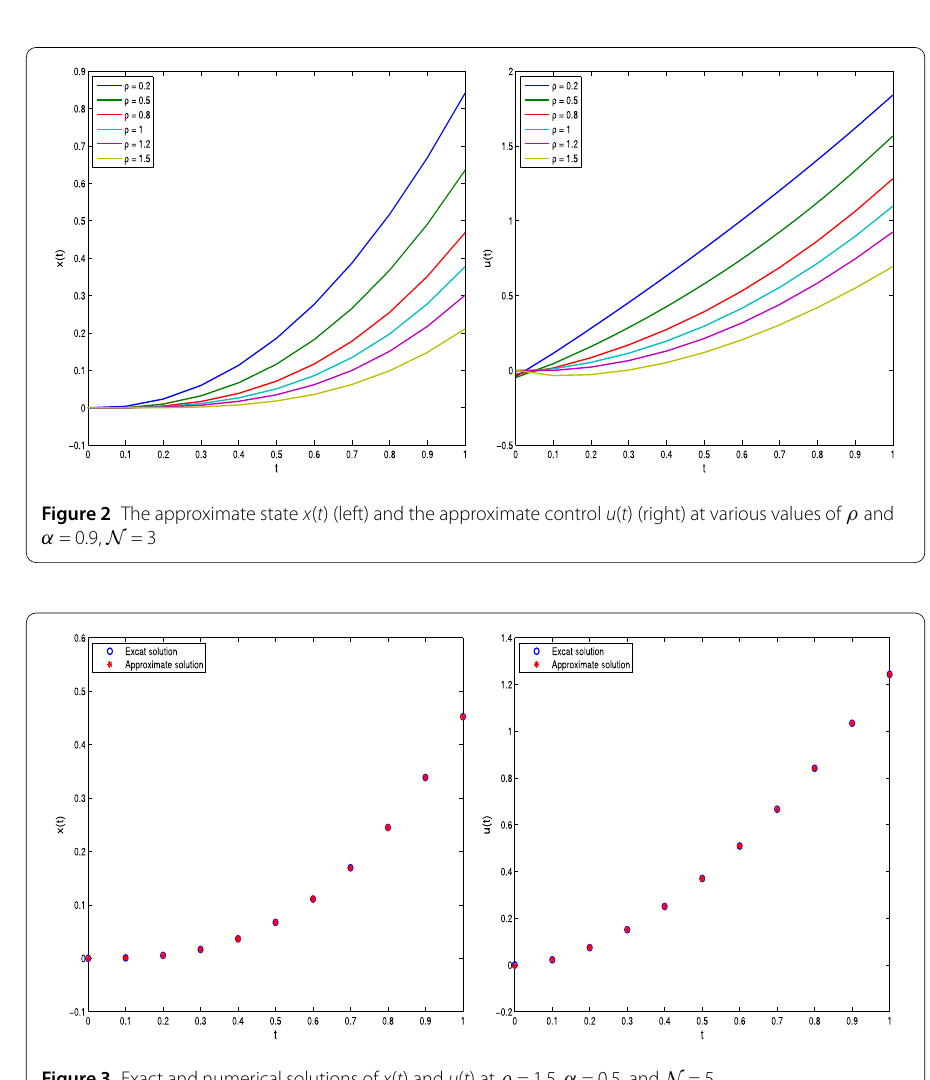
Figure 3 Exact and numerical solutions of x ( t ) and u ( t ) at ρ = 1.5, α = 0.5, and N =